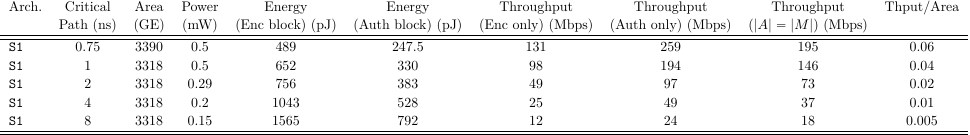
Table 11: The design space of Romulus - N 1 using the TSMC-65 ASIC technology: byte serial implementations